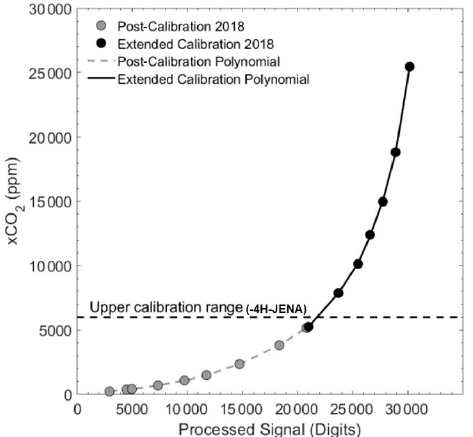
Figure 4. Calibration polynomial from the post-cruise manufacturer calibration (grey dots; KMCON) and the manual extended calibra- tion curve (black dots), with the top range of the KMCON cali- bration range indicated (dashed line) above which the non-linear behaviour of the non-dispersive infrared (NDIR) spectrometry sen- sor becomes stronger. The processed signal was calculated from the raw and reference signal data during